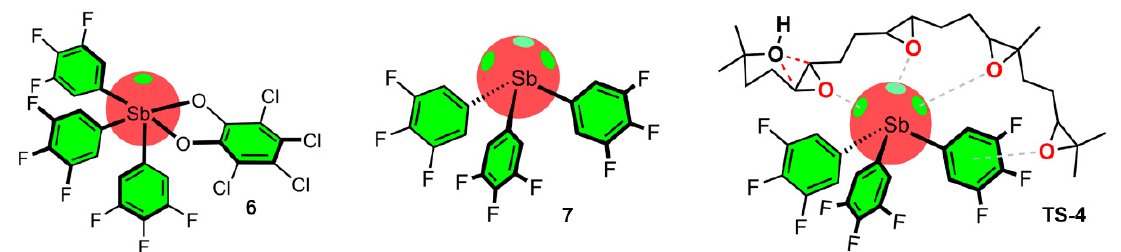
Figure 7. Schematic representation of several catalysts including multiple pnictogen bonding for cascade cyclization of a tetraepoxide on Sb(III) catalyst [94] (TS-4).